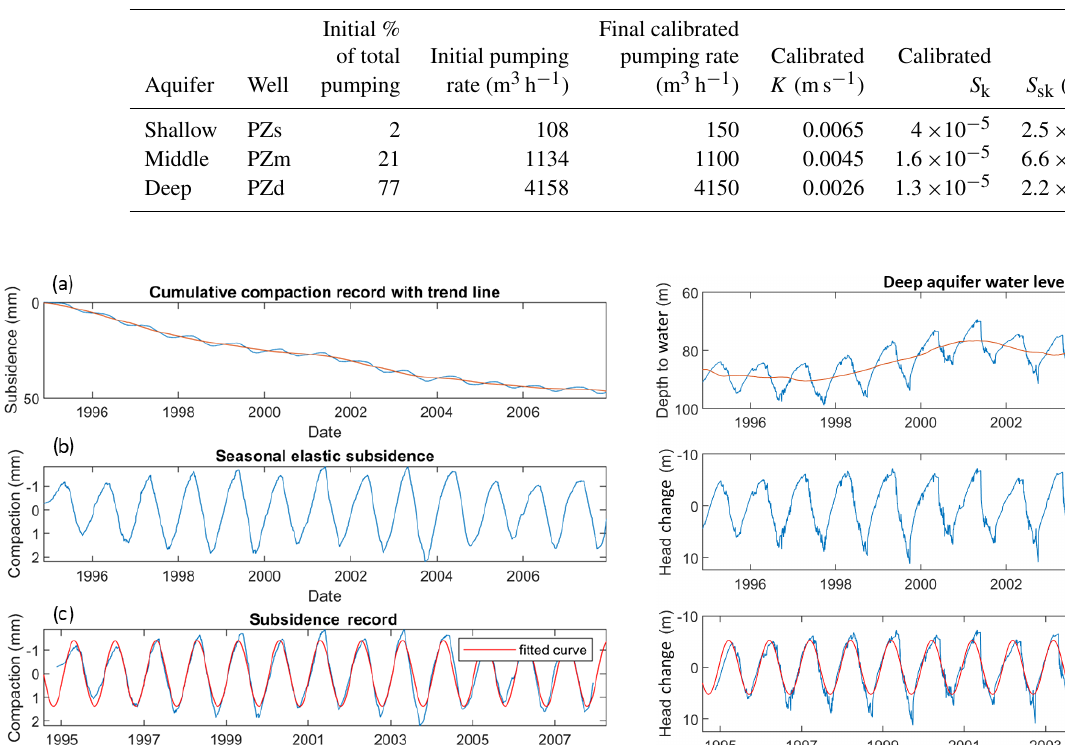
Table 1. Calibrated hydraulic conductivity and storage parameters for the shallow, middle and deep aquifers using the Theis equation (Eq. 1) for cyclical daily pumping.